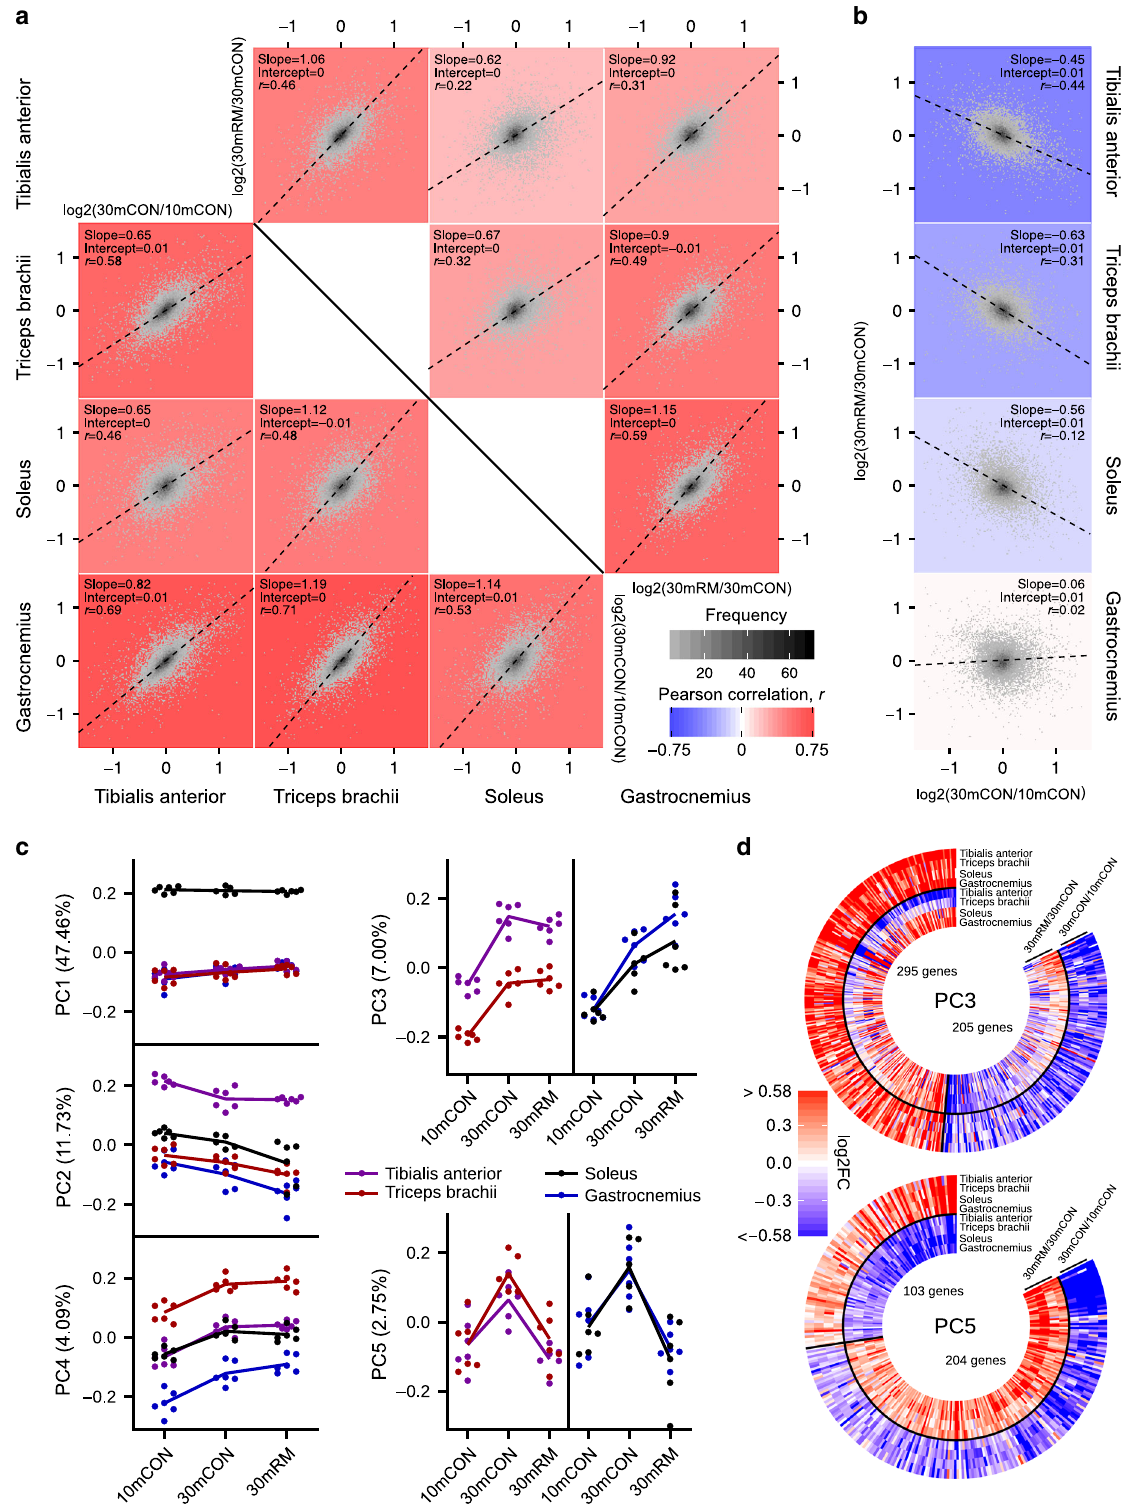
partially protected (SOL) and not protected (GAS) by rapamycin, correlations were very weakly negative ( r = − 0.12, s = − 0.56) and nonexistent ( r = 0.02, s = 0.06, Fig. 5b), respectively. Hence, muscle-speci fi c gene expression responses to rapamycin closely re fl ect rapamycin-induced changes in muscle mass (Fig. 2a). independent of age and treatment (Fig. 5c and